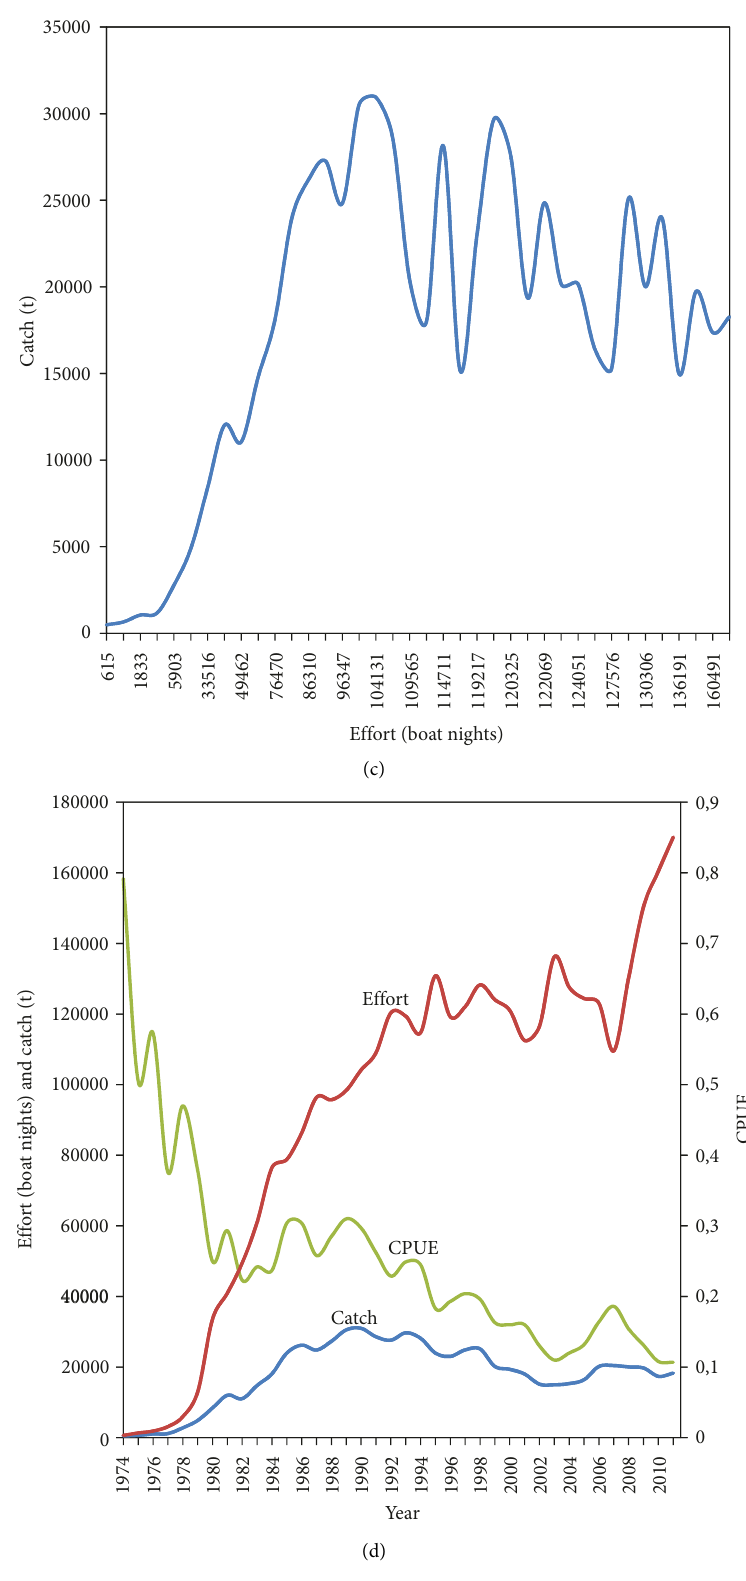
Figure 3: (a) Kapenta catch and CPUE time series plot; (b) a plot of monthly averages of kapenta catch and CPUE; (c) kapenta catch in Lake Kariba time series plot; (d) a plot of effort and CPUE in Lake